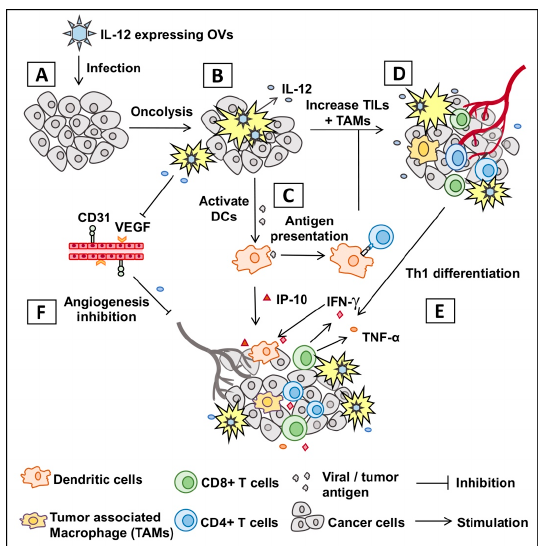
Figure 1. Graphic presentation of mechanism of action of oncolytic virus encoding IL-12. ( A ) Infection of tumor with oncolytic virus encoding IL-12 (OV-IL12). ( B ) OV-IL12 replicates in and kills cancer cells (i.e., oncolysis) and releases IL-12 in the tumor microenvironment. ( C ) Neoantigens from lysed cancer cells activate and recruit dendritic cells (DCs) into the tumor microenvironment. DCs process neoantigens, travel to nearest lymphoid organs, and present the antigen to T cells (CD4 + and CD8 + T cells). ( D – E ). T cells migrate to the site of infection (referred as tumor-infiltrating T cells or TILs), differentiate into Th1 cells, produce anti-tumor cytokines and kill cancer cells. ( F ) IL-12-induced production of IFN- γ and interferon inducible protein 10 (IP-10) produces anti-angiogenetic effect through reduction of tumoral vascular endothelial growth factor (VEGF) and CD31 + tumor endothelial cells. 2. Genetically Engineered IL-12 Expressing OHSVs and Their Therapeutic Efficacy 2.1. IL-12 Insertion Does Not Compromise Safety and Tumor Specificity of Genetically Modified OHSV-IL12 Viruses Herpes simplex virus type 1 (HSV-1) has a large 152 kb genome, and therefore, deletion or mutation of various genes (Figure 2) does not fundamentally alter its functional properties (such as infectivity, viral replication, etc.), but rather confers tumor cell-specific replication, with no or reduced toxicity (e.g., neuropathogenicity) [59]. For example, G47 Δ -IL12 (an IL-12 expressing OHSV) has three genomic modifications that endow its tumor-specificity and safety: ICP6 inactivation, γ - (ICP)34.5 and ICP47 deletion, and IL-12 insertion [30,60]. ICP6, encodes for viral ribonucleotide reductase, controls nucleotide metabolism and helps HSV to replicate in healthy or non-dividing cells that are inherently lacking sufficient nucleotide pools [59,61] (Figure 3A). ICP6 inactivation by fusion of LacZ does not hamper DNA synthesis in cancer cells (Figure 3B) [59,62] but the lack of ribonucleotide reductase results in no nucleotide metabolism and no viral DNA replication in healthy